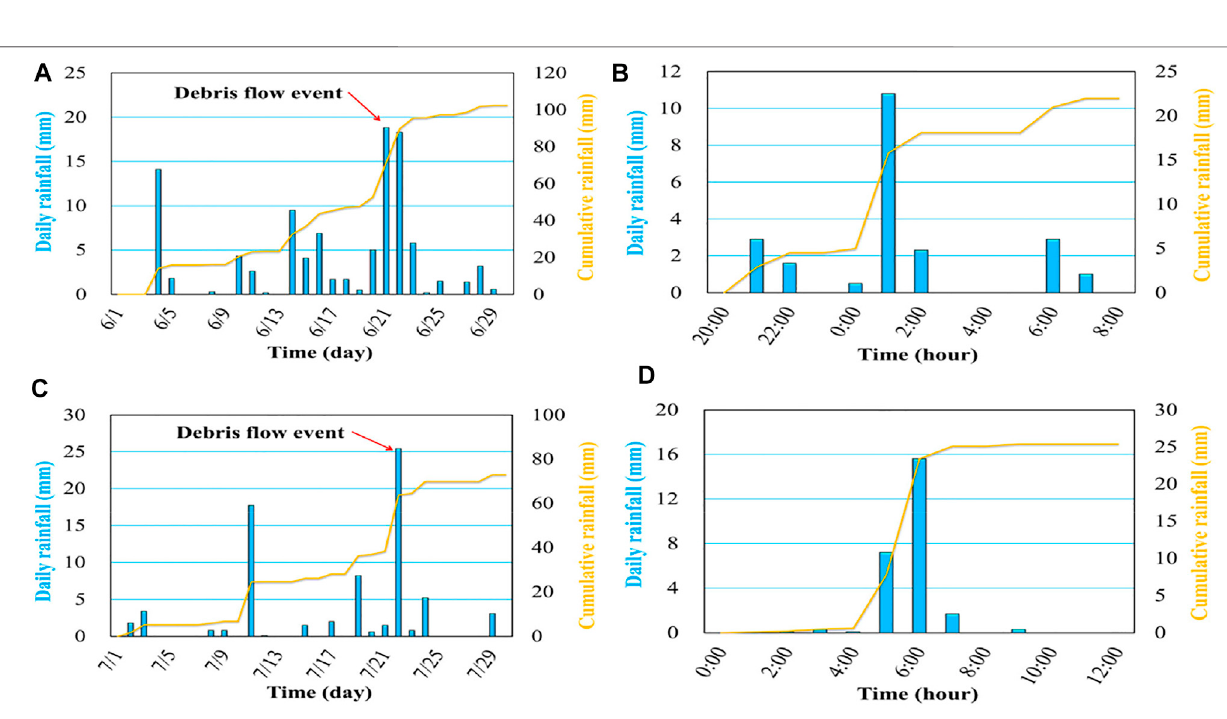
Frontiers in Earth Science |